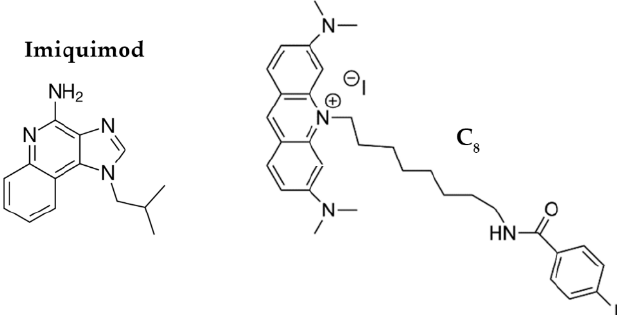
Figure 1. Chemical structures of Imiquimod and 10-(8-(4-iodobenzamide) octyl)-3,6-bis (dimethylamine) acridinium iodide (C 8 ).